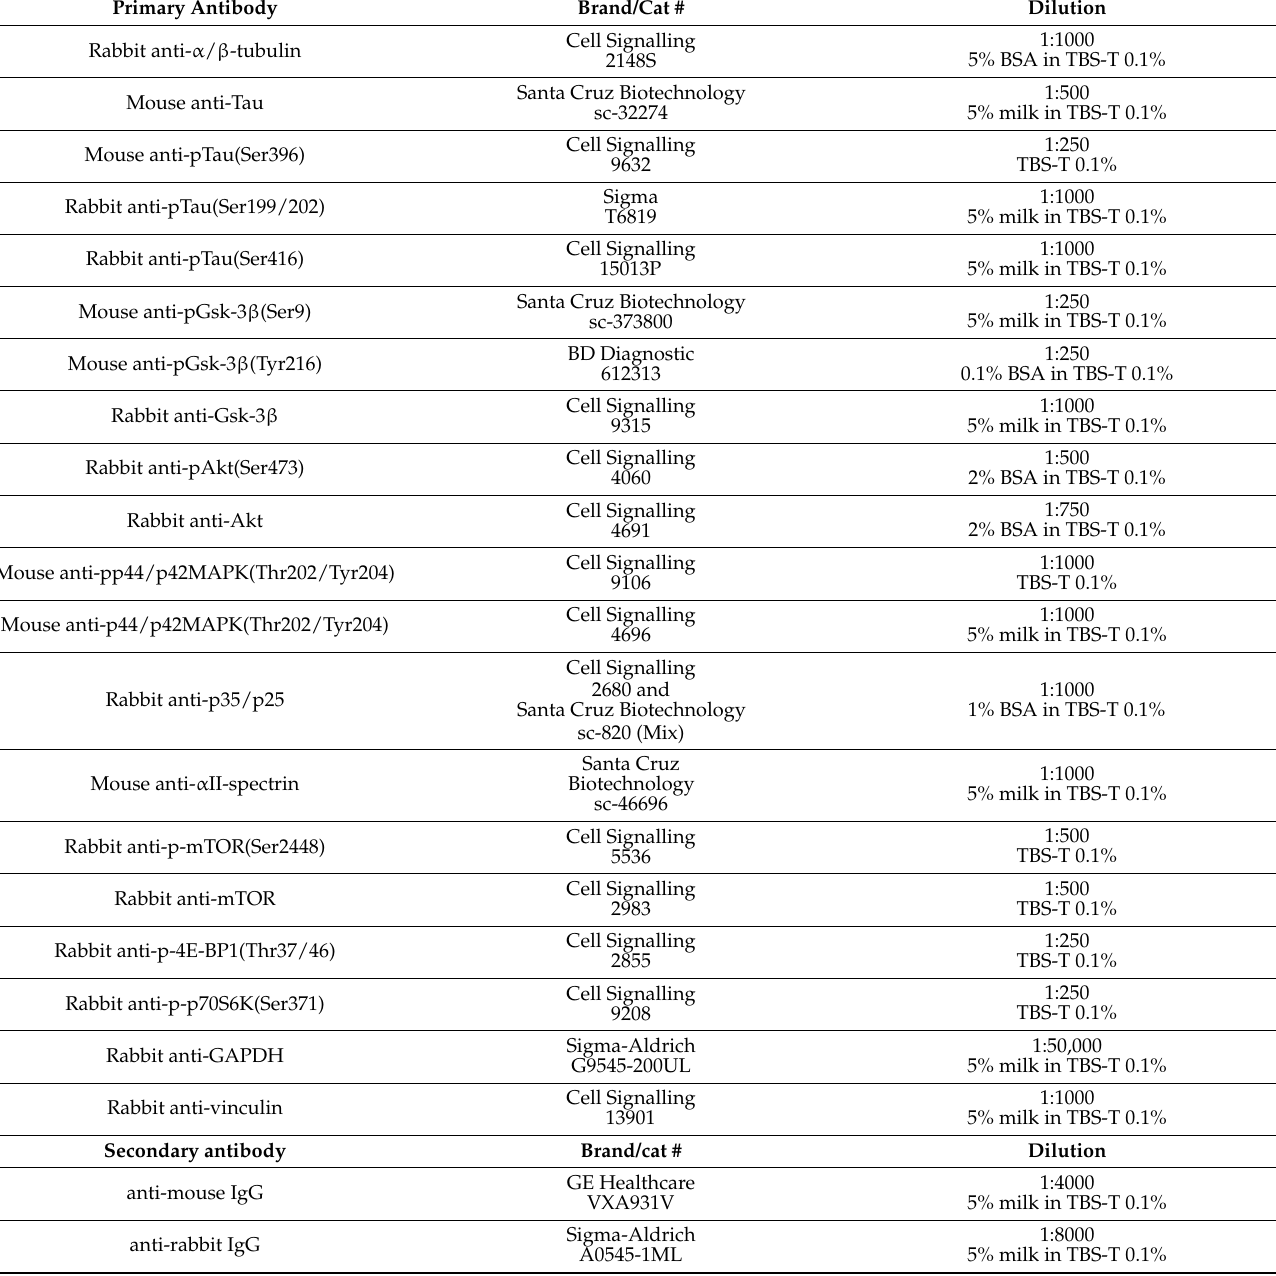
Table 1. Experimental conditions used to perform the Western blot